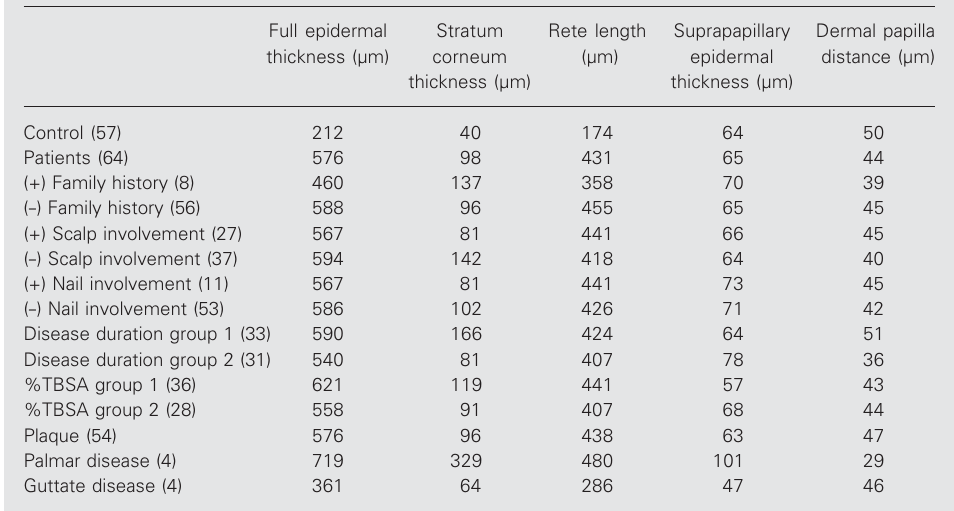
Table 1. Epidermal thickness measurements of psoriasis patients and